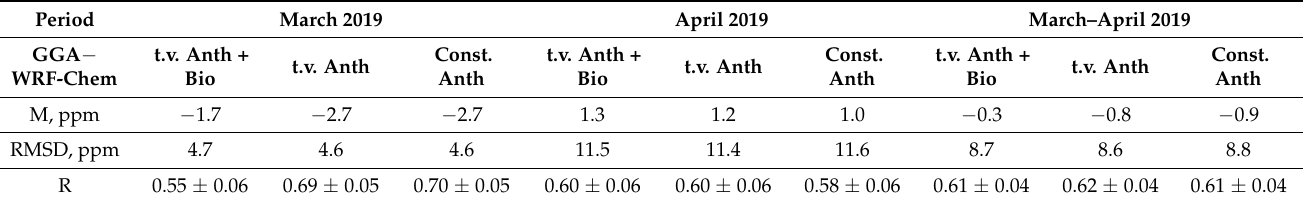
Table 7. Statistical characteristics of difference between the WRF-Chem and observation data for Peterhof in March and April 2019. Here, t.v. is temporal variation and t.conss. is time constant.